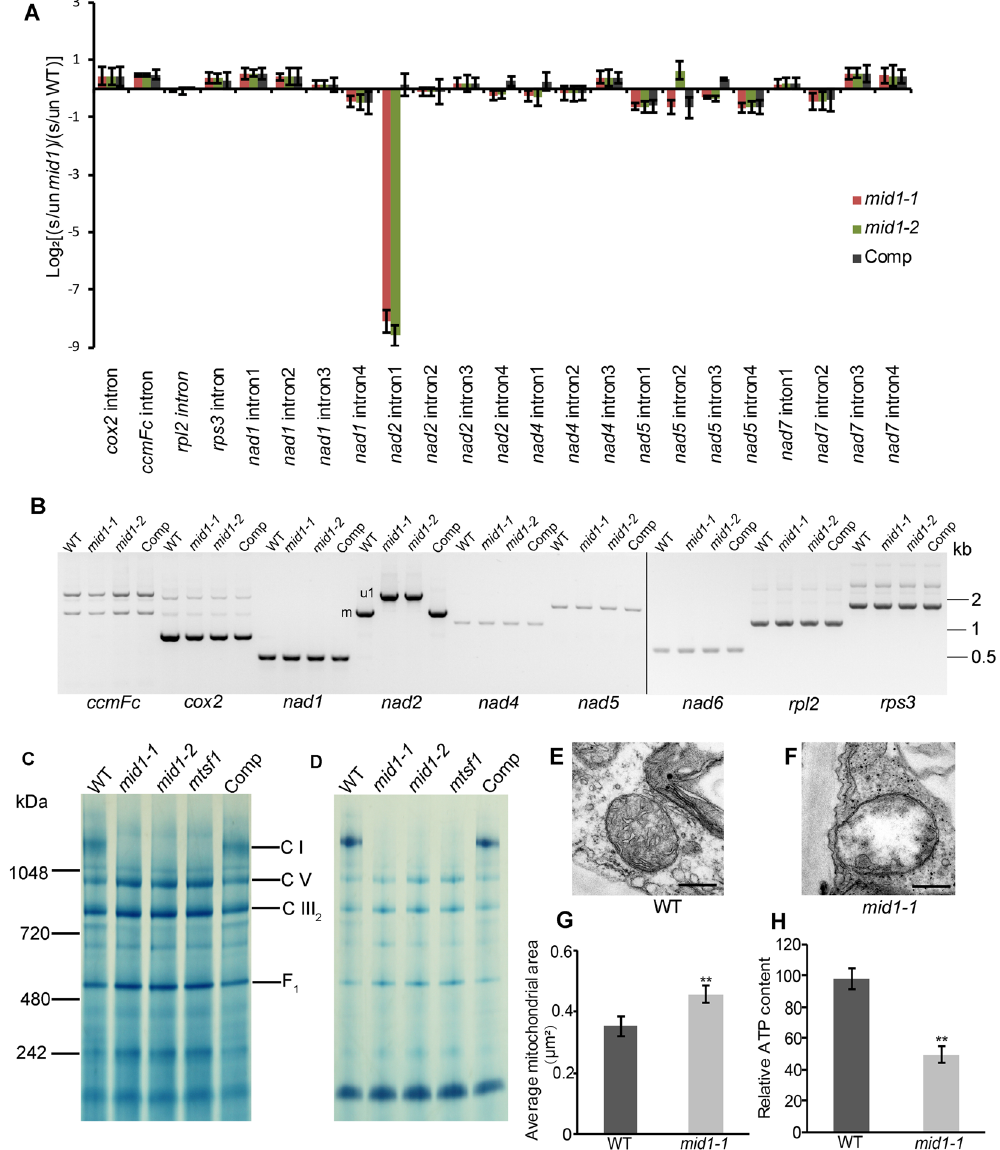
Figure 5. Functional analysis of MID1 in mitochondria. ( A ) qRT-PCR analysis of splicing efficiency of mitochondrial introns in mid1 . The histograms display the ratio of the spliced transcripts to the unspliced transcripts in mid1 plants as compared with wild-type in a log 2 form. Each mean value is the average of three biological replicates, each of which undergoes triple repeats. s, spliced transcripts; un, unspliced transcripts. ( B ) RT-PCR analysis of mitochondrial transcripts splicing efficiency. u1 means nad2 transcript with intron 1.m means mature nad2 transcript. comp, MID1Pro:MID1 -3 × Flag complemented line. ( C ) BN-PAGE analysis of mitochondrial protein complexes abundance in wild-type, mid1 mutants, mtsf-1 and complemented line. Protein marks are indicated in the left panel and the bands representing main protein complexes are listed in the right panel. ( D ) In-gel analysis of complex I activity in wild-type, mid1 mutants, mtsf1 and complemented line. comp, MID1Pro:MID1 -3 × Flag complemented line. Transmission electron microscopy analysis of mitochondrial ultrastructure in leaf of 4-week-old WT ( E ) and mid1-1 ( F ). Bars = 0.5 μ m. ( G ) Mitochondrial area of wild-type and mid1-1 . Data are the mean ± SE, n = 140. Student’s t tests, * P < 0.05. ( H ) ATP content in the leaf of wild-type and mid1-1 , Student’s t tests, ** P <